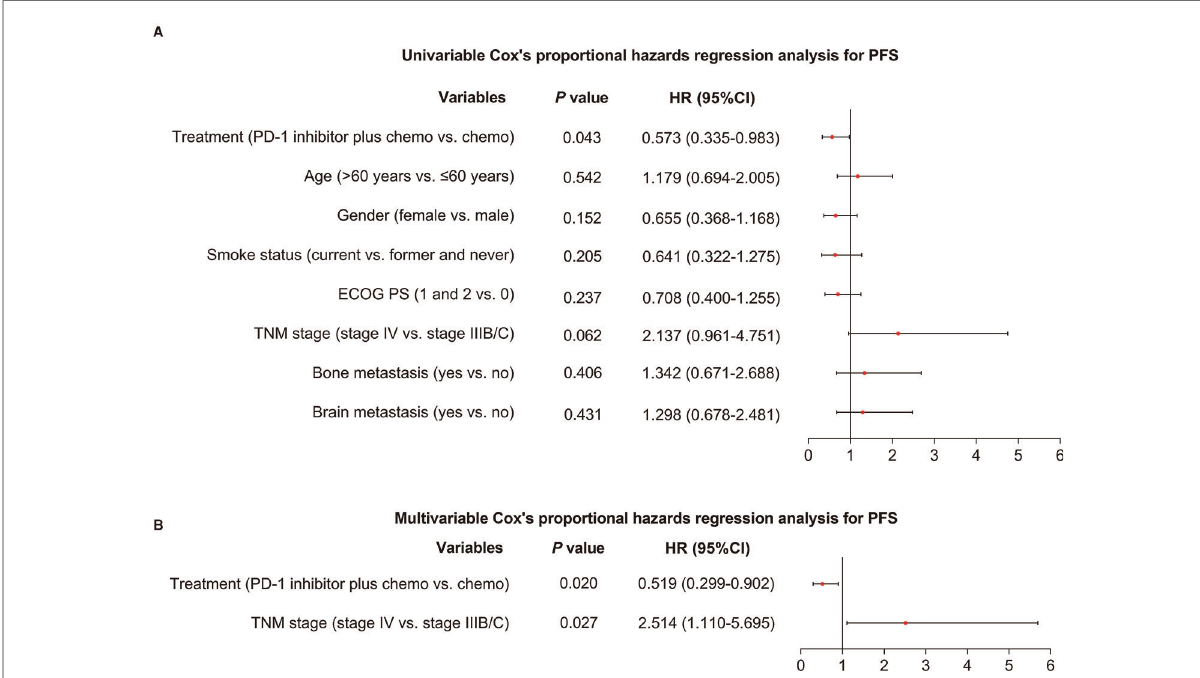
FIGURE 2 Factors affecting PFS. Univariable ( A ) and multivariable ( B ) Cox ’ s proportional hazards regression analysis for PFS in advanced driver-gene-negative nonsquamous NSCLC